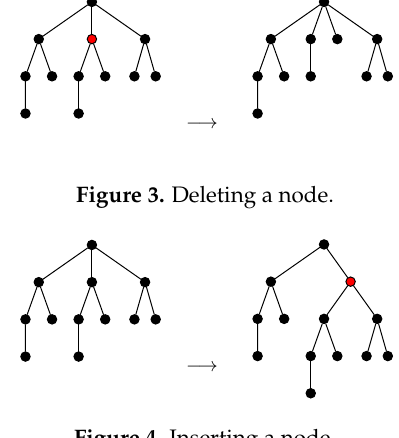
Figure 4. Inserting a